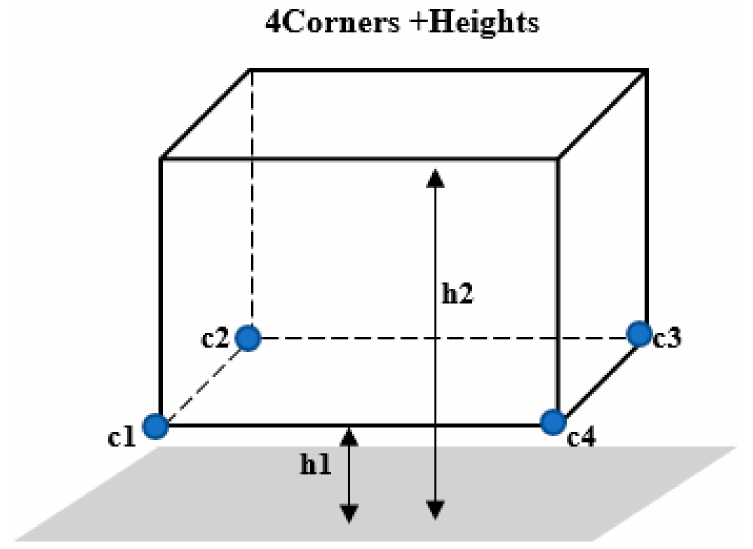
Figure 7. Three-dimensional bounding box